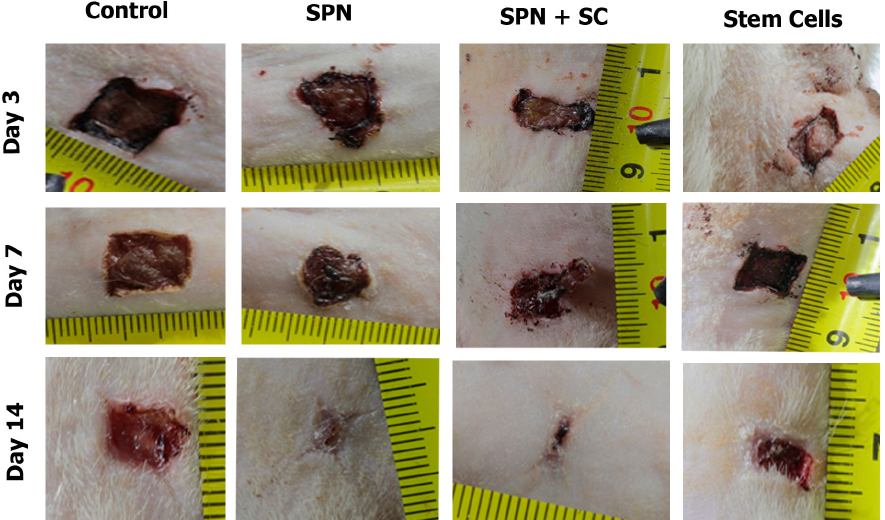
Figure 7. The visual dynamics of wounds in different groups.